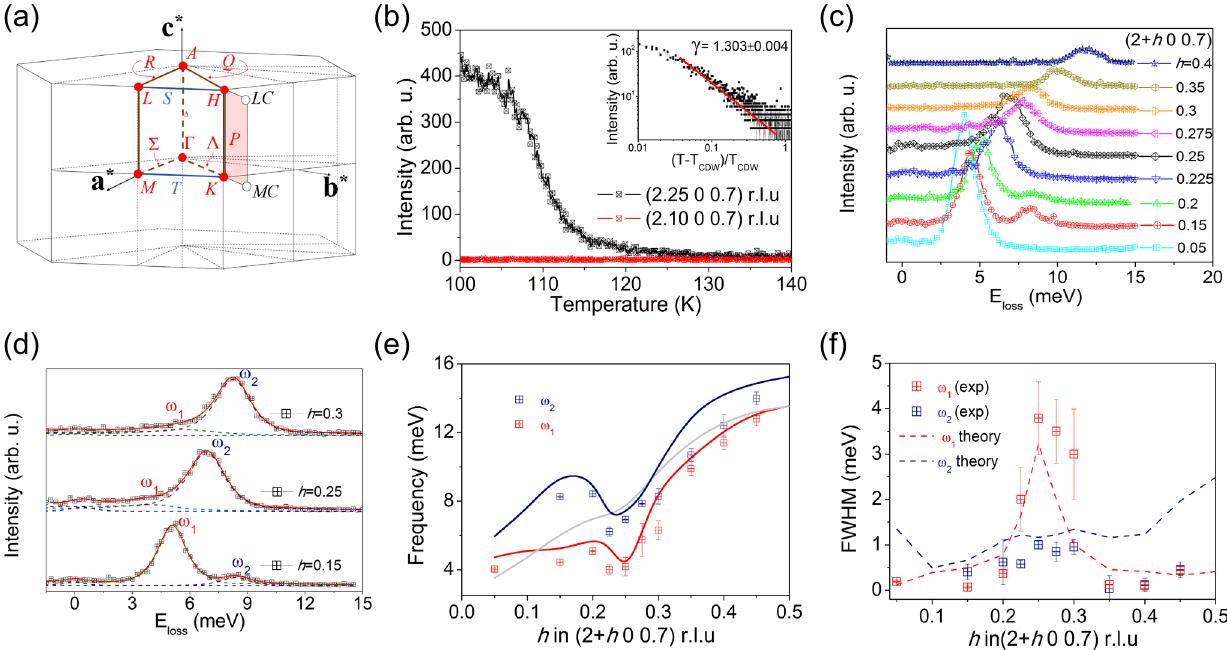
Fig. 1 Elastic peak, CDW, and lattice dynamics at 300 K. a The Brillouin zone of space group P 3m1 (164) 52 . b Temperature dependence of the elastic line at (2.25 0 0.7) r.l.u. (reciprocal lattice unit) showing the onset of the CDW at 110 K. Inset, scaling analysis of the elastic peak. c Energy-momentum dependence of the low-energy acoustic phonons at 300 K from 0.05 < h < 0.4 r.l.u. along the (2 + h 0 0.7) direction. The spectra are vertically offset for clarity. d Close-up view of the phonon fi tting at 300 K for selected momentum transfers, identifying the ω 1 and ω 2 phonons. e Experimental (points) and calculated (solid lines) dispersion of the low-energy acoustic phonons at 300 K. The gray line stands for the silent mode, not observed experimentally. f Momentum dependence of the linewidth for ω 1 and ω 2 obtained from the fi tting of the experimental spectra to damped harmonic oscillators. In panels ( e ) and ( f ), the error bars represent the fi t uncertainty. The calculated linewidth including the contribution of the electron – phonon interaction and anharmonicity is shown as dashed